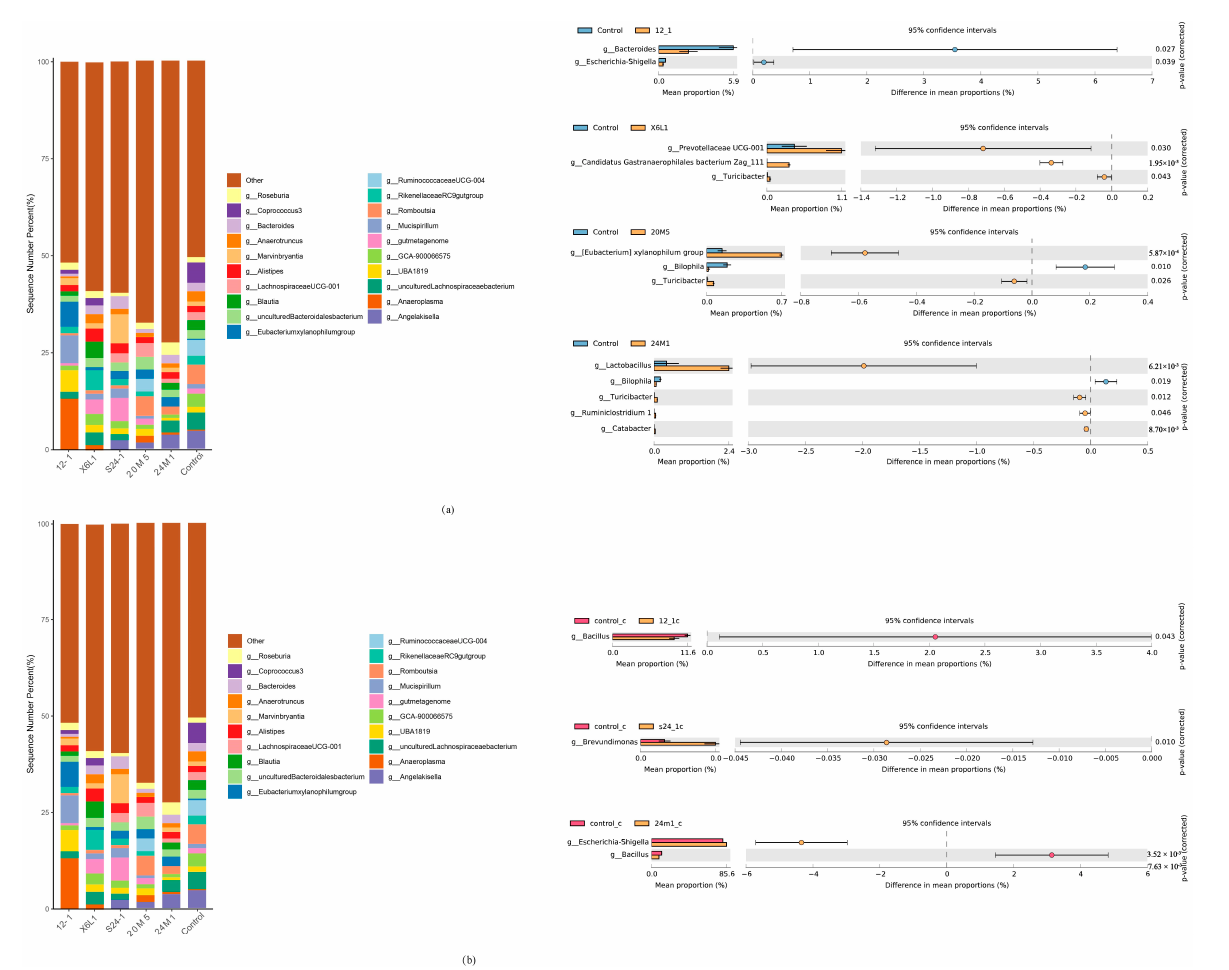
Figure 6. Effect of L. fermentum on gut microbiota in mice at genera level. ( a ) Relative abundance of bacteria in mouse colon and bacteria with differences by Welch’s t test at genus level; ( b ) Relative abundance of IgA-coated bacteria in mouse colon and bacteria with differences by Welch’s t test at genus